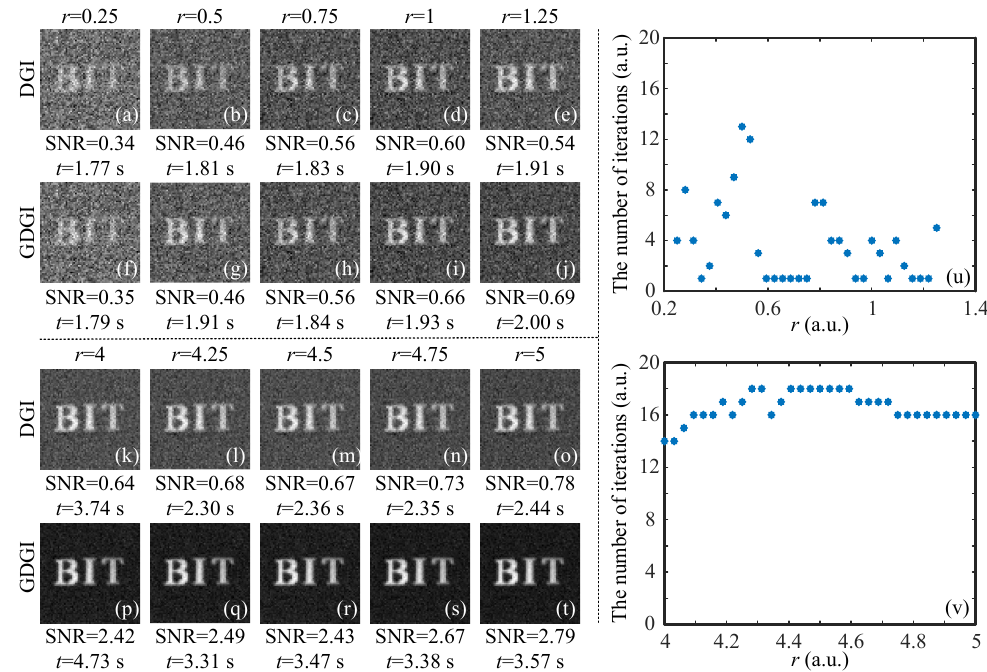
Figure 9. Comparison results of the binary object “BIT”. ( a – t ) are the reconstructed images of the DGI and GDGI using different sampling rates; ( u , v ) give the change in the number of iterations with the sampling rate, all using the GDGI.